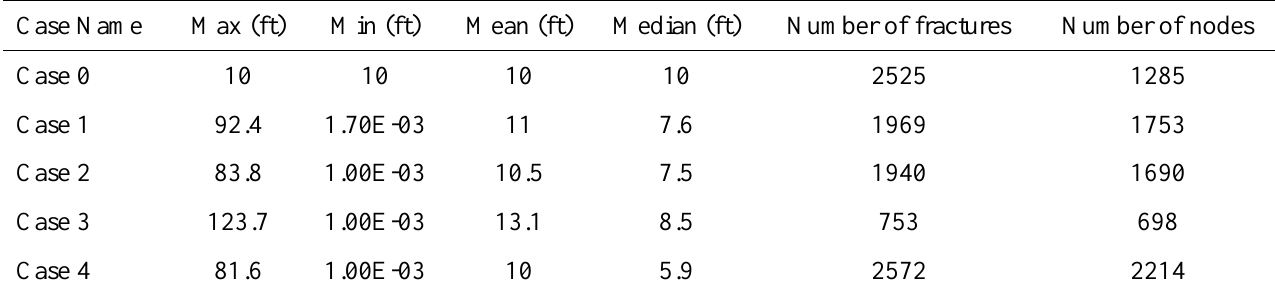
Table 1—Statistics for the fracture network in various Cases.